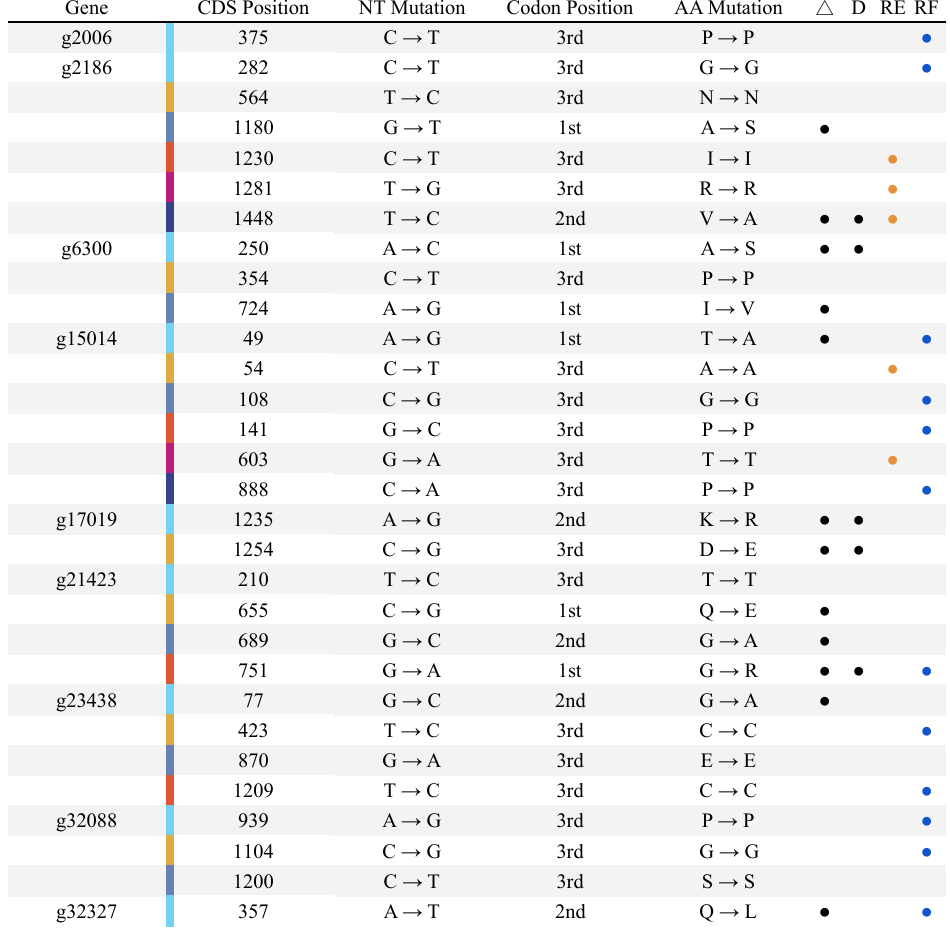
Figure 5. Characteristics of the 30 identified DOF SNPs in Eugenia uniflora . For every SNP, the gene, CDS mutation position, nucleotide mutation, codon position, and amino-acid changes are shown. The last four columns indicate, in order, a non-synonymous mutation ( ∆ ), a mutation inside a motif (D), RE specificity, and RF